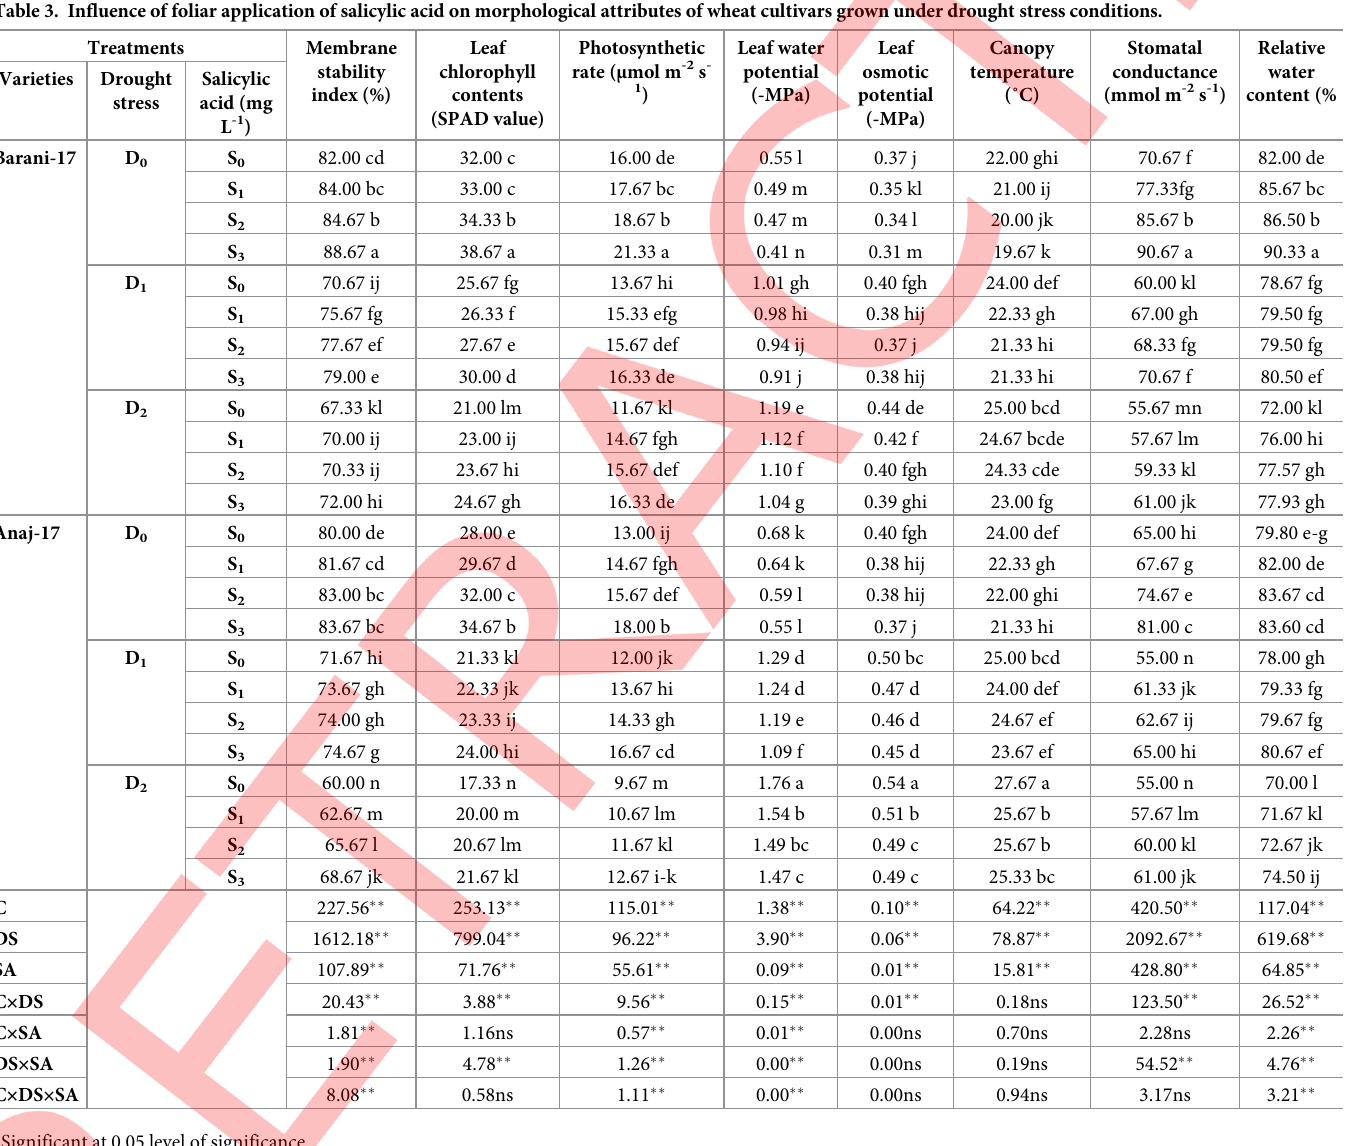
Table 3. Influence of foliar application of salicylic acid on morphological attributes of wheat cultivars grown under drought stress conditions. Treatments Membrane